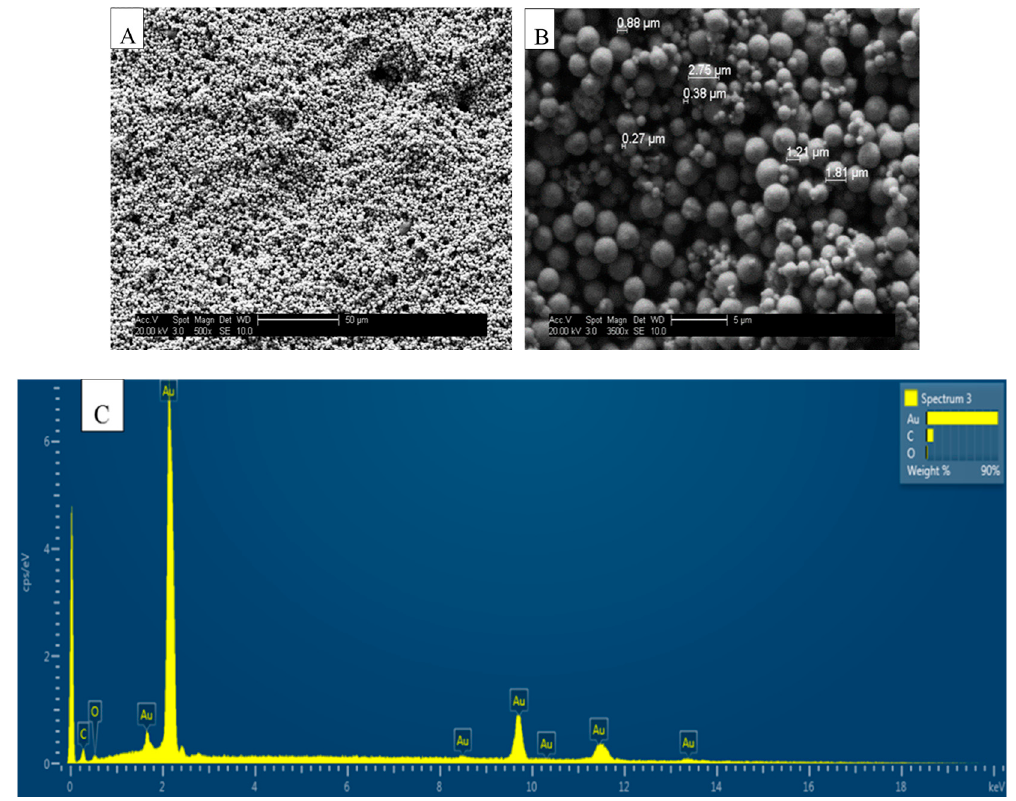
Figure 2. SEM of a JD2b bare electrode, ( A ) at 500×, ( B ) at 3500×, ( C ) ESEM surface analysis of JD2b.